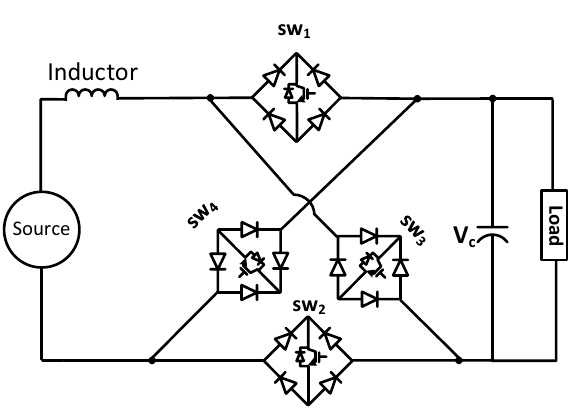
Figure 1. The circuit